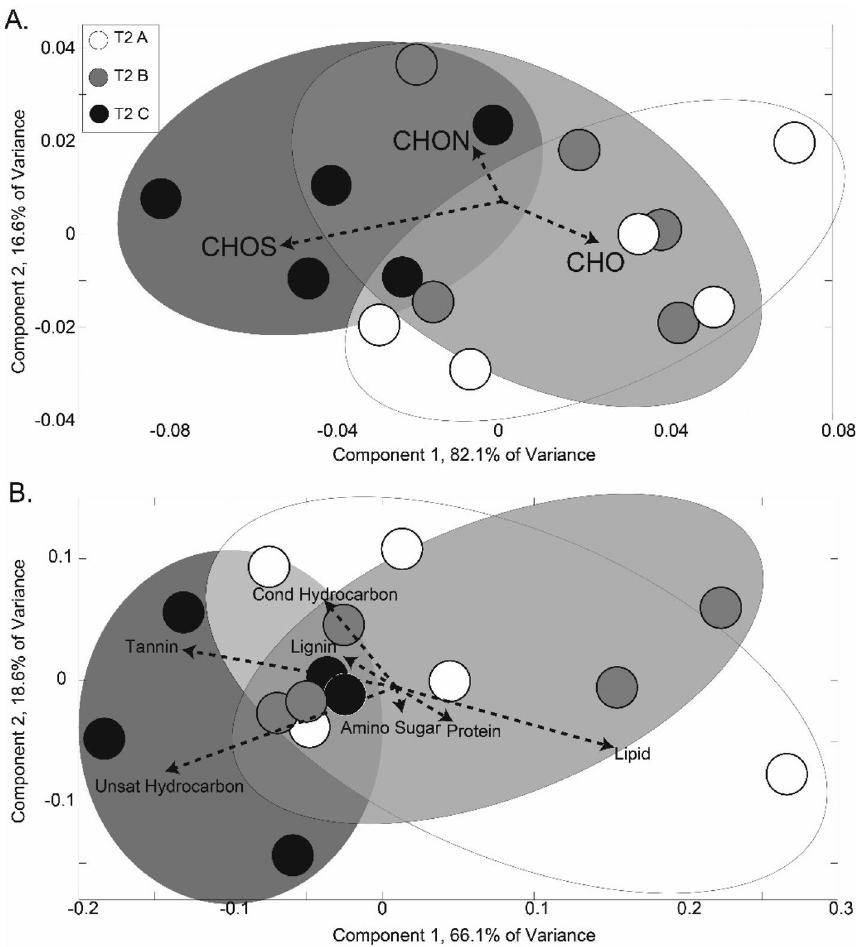
Figure 4. FTICR PCA plots exhibited the drought severity treatment gradient from treatment A (control), B (mild), to C (severe) at T2 by elemental composition ( A ) and compound class ( B ). Elemental composition class CHOS ( A ) and compound class tannins and unsaturated hydrocarbons ( B ) were associated with treatment C at T2 (after treatment). FTICR PCA plots comparing treatments A, B, and C at T1 (before treatment) are presented in Fig. S8. Arrows are vectors whose length indicates the loading score and how strongly each compound class influences a principal component. Angles between the vectors that are less than 90° represent positive correlation and above 90° represent negative